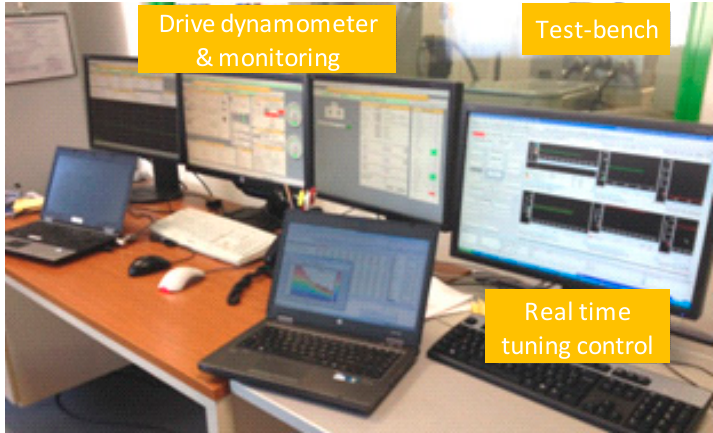
Figure 5. Tuning of motor drive in the real-time control platform of the high-speed test-bench.